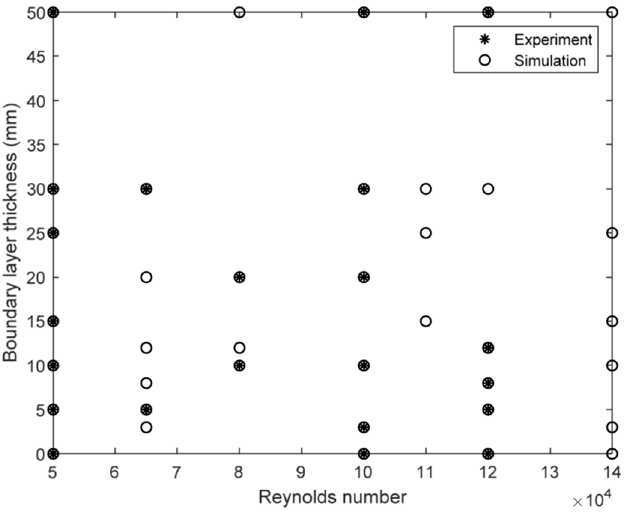
Figure 1. Design of experiments for both low-fidelity (LF) and high-fidelity (HF)